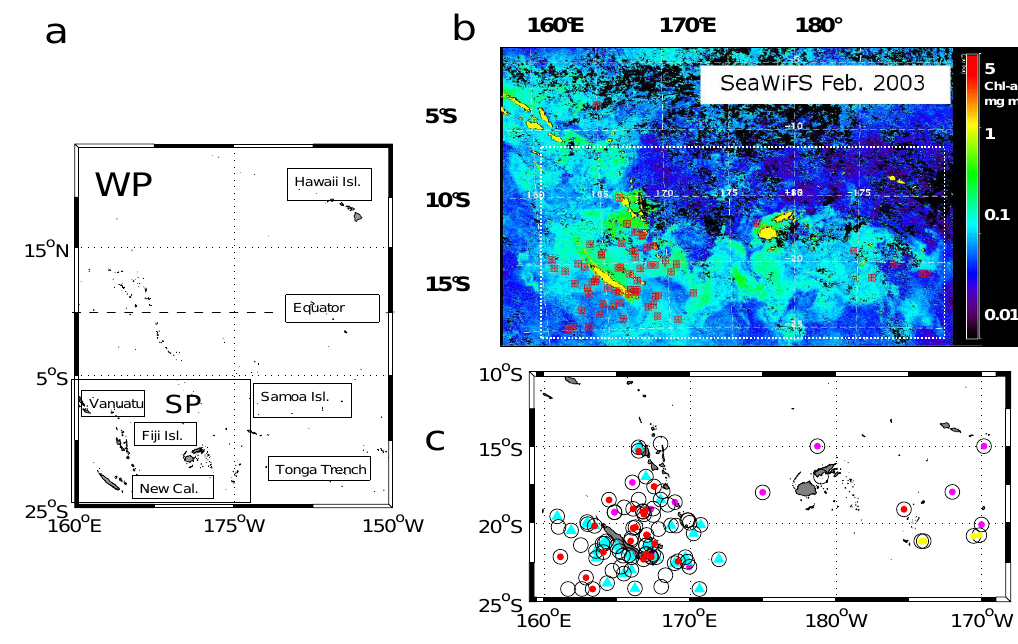
Fig. 1. (a) Map showing limits of the Western Pacific Ocean (WP: 25 ◦ N–25 ◦ S/160 ◦ E–160 ◦ W) and of the Southern Pacific Ocean domains (SP: 5 ◦ S–25 ◦ S/150 ◦ E–170 ◦ W). (b) Mean SeaWiFS composite image of chlorophyll- a (mgm − 3 ) in the SP Ocean in February 2003 (austral Summer) with observations of Trichodesmium surface accumulations for December 2002–March 2003. Main islands are indicated in yellow: New Caledonia (20–22 ◦ S, 165 ◦ E), Vanuatu (15–20 ◦ S, 168 ◦ E), Fiji (17 ◦ S, 180 ◦ E) and South Tonga Islands (21 ◦ S, 175 ◦ W). (c) French Navy observations of Trichodesmium surface blooms (1998–2010) from Table 1 as empty black circles, with: light blue – aerial observations; red – small form filaments (named T. erythraeum spp. after Ten´orio, 2006); magenta – mix of small T. erythraeum and long forms (filaments of Trichodesmium thiebautii and T. tenue ); yellow – mix of T. tenue and Katagnymene sp.